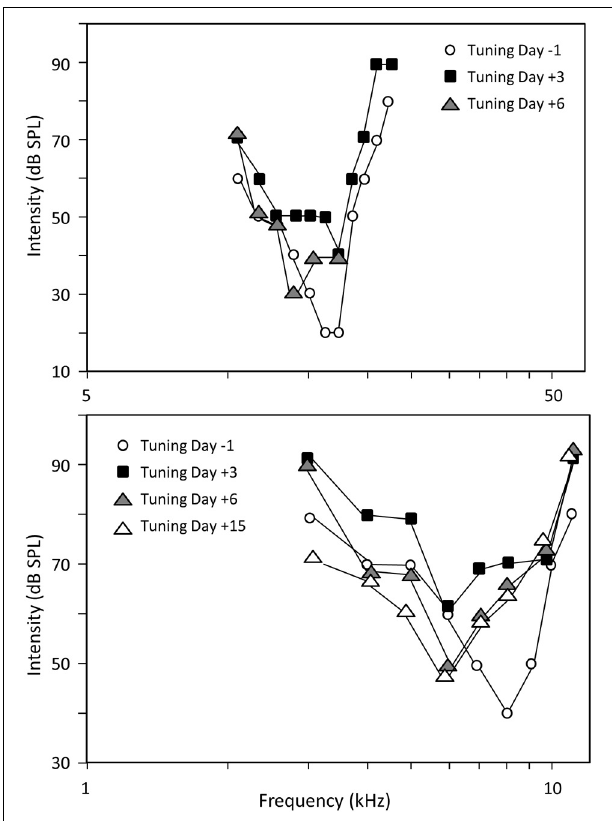
FIGURE 3 | Frequency shifts of two cortical tuning curves. Frequency tuning curves of two individual neurons (top and bottom). For each neuron, the tuning curve is represented the day before the trauma (white circles), 3 days (black square) and 6 days (gray triangle) after the trauma. The decrease in threshold value at CF from D + 3 to D + 6 might reflect a putative transition between TTS and PTS.